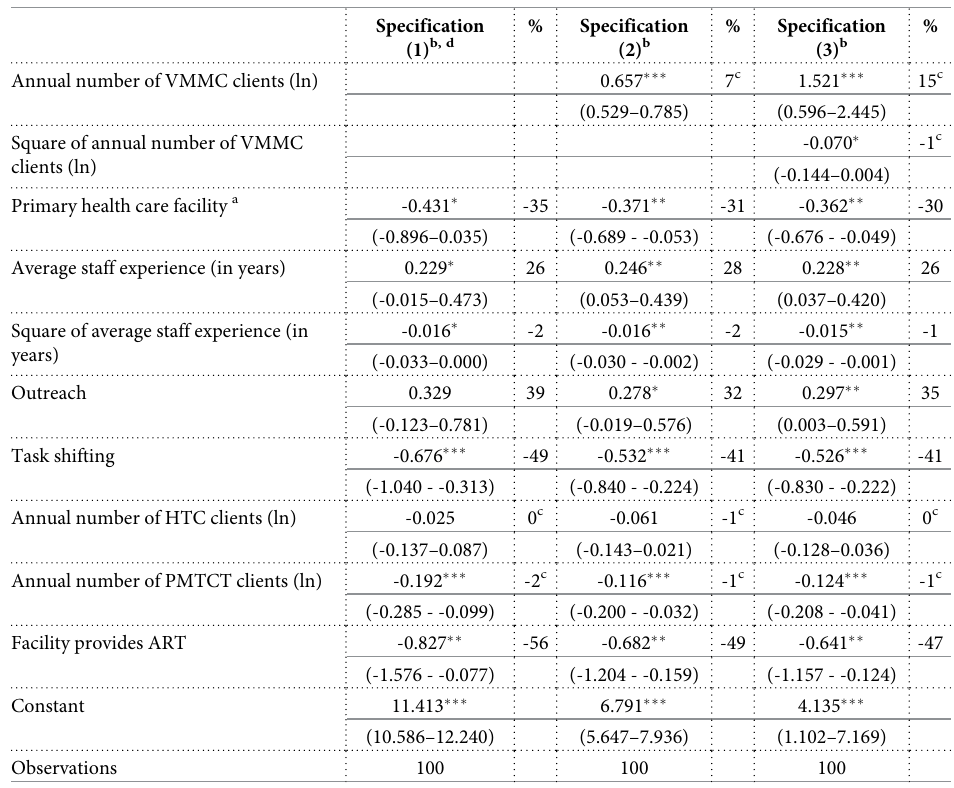
Table 2. GLM regression models. Dependent variable is the natural logarithm of the facility-level total cost of VMMC services.